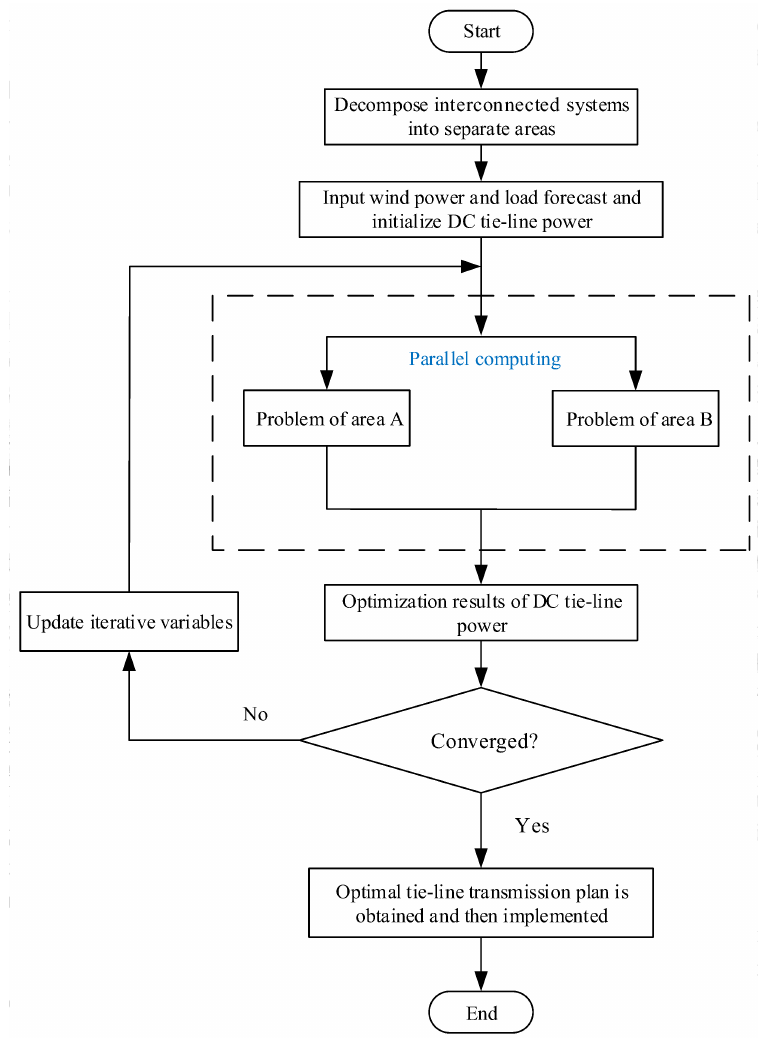
Figure 3. Flow chart of model solving based on the